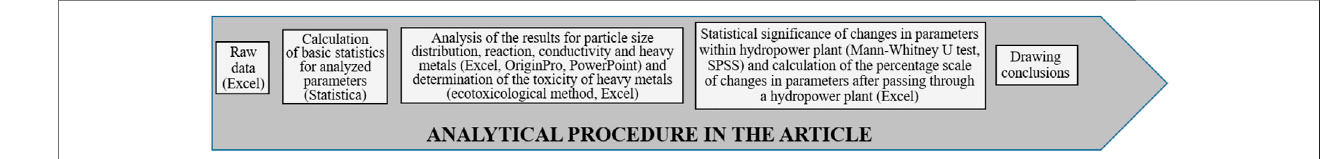
FIGURE 4 | Analytical procedure in the article.